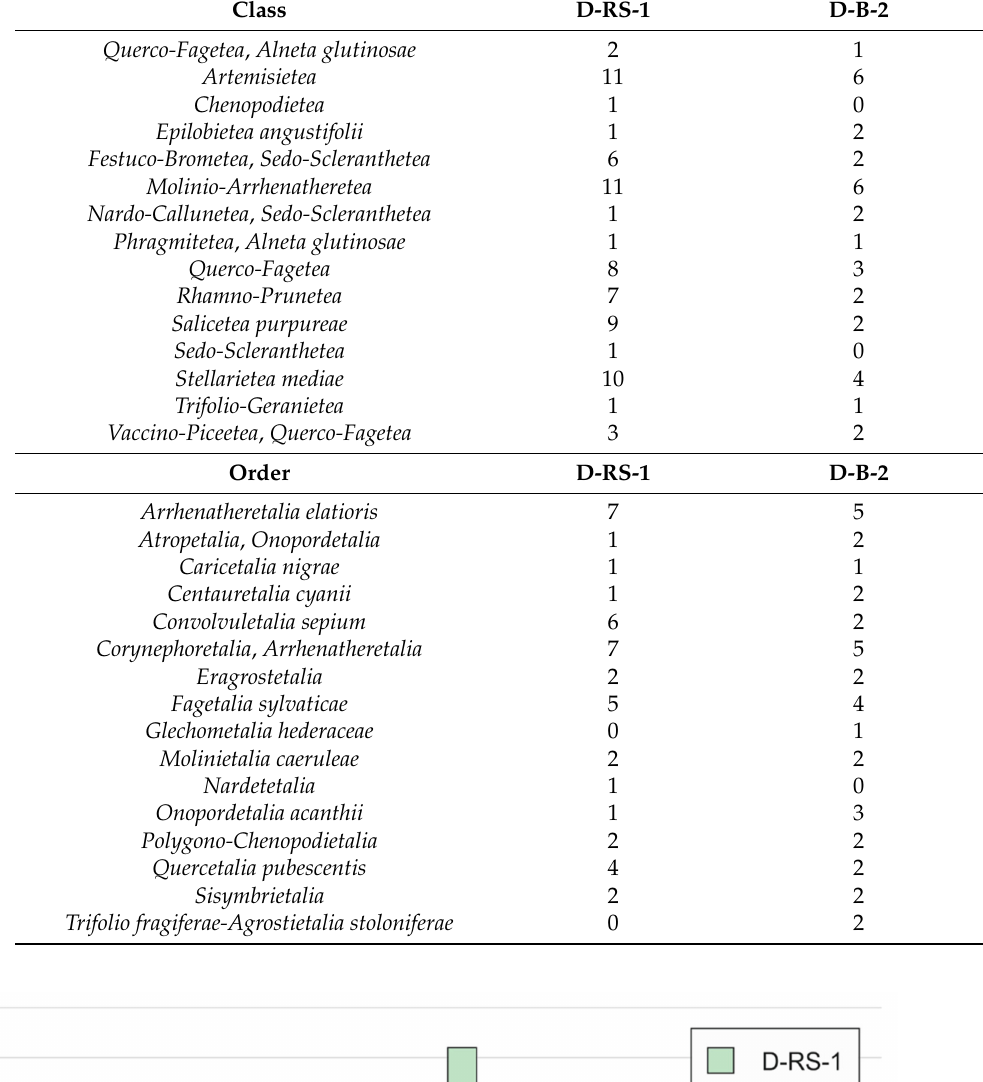
Table 4. Syntaxonomic affiliation of flora at the level of classes and orders.